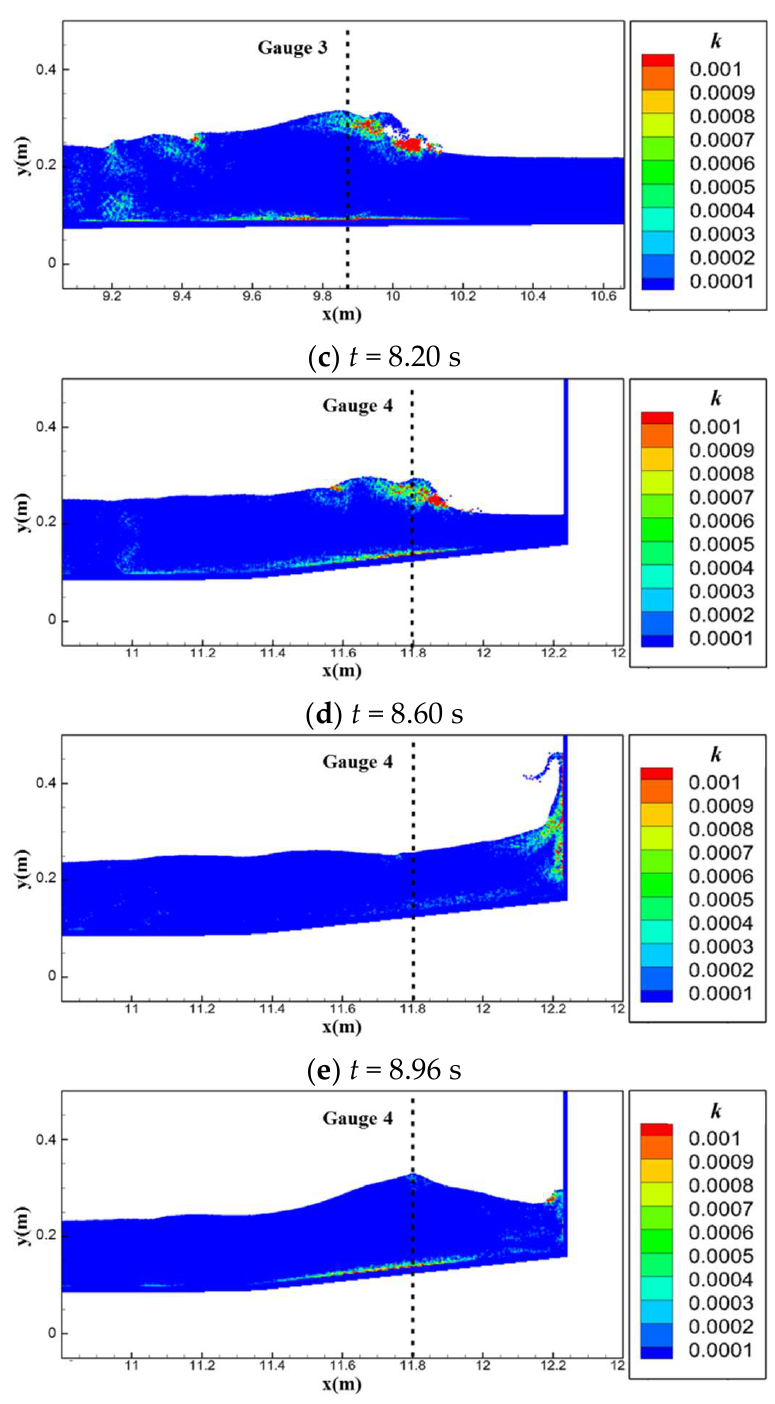
Figure 16. Time-sequence of turbulent intensity field during wave run-up process including wave breaking and impinging over a vertical slope for case 2.